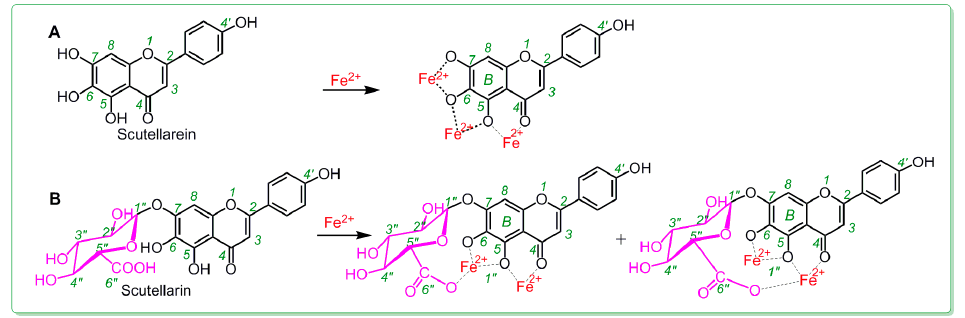
Figure 6 Proposed Fe 2+ -binding reactions of scutellarein ( A ) and scutellarin ( B ).